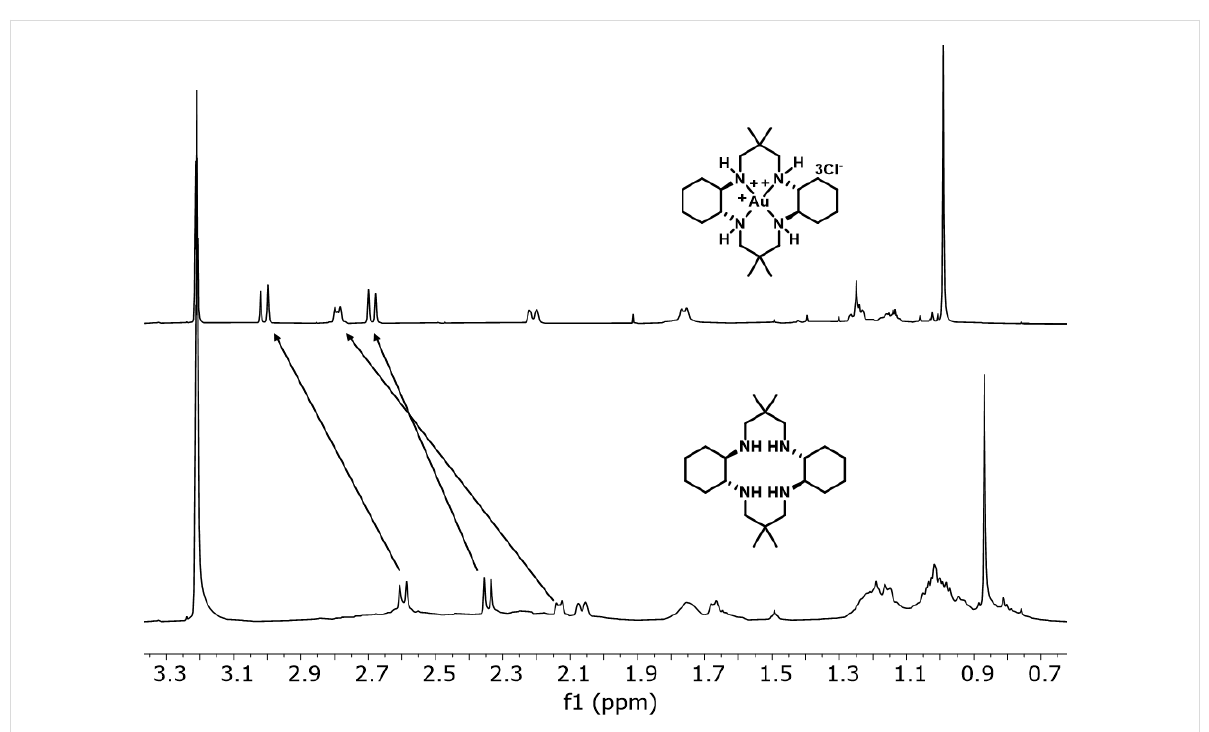
Figure 1: 1 H NMR study of the formation of complex 6a -Au(III) by AuCl 3 coordination to ligand 6a .